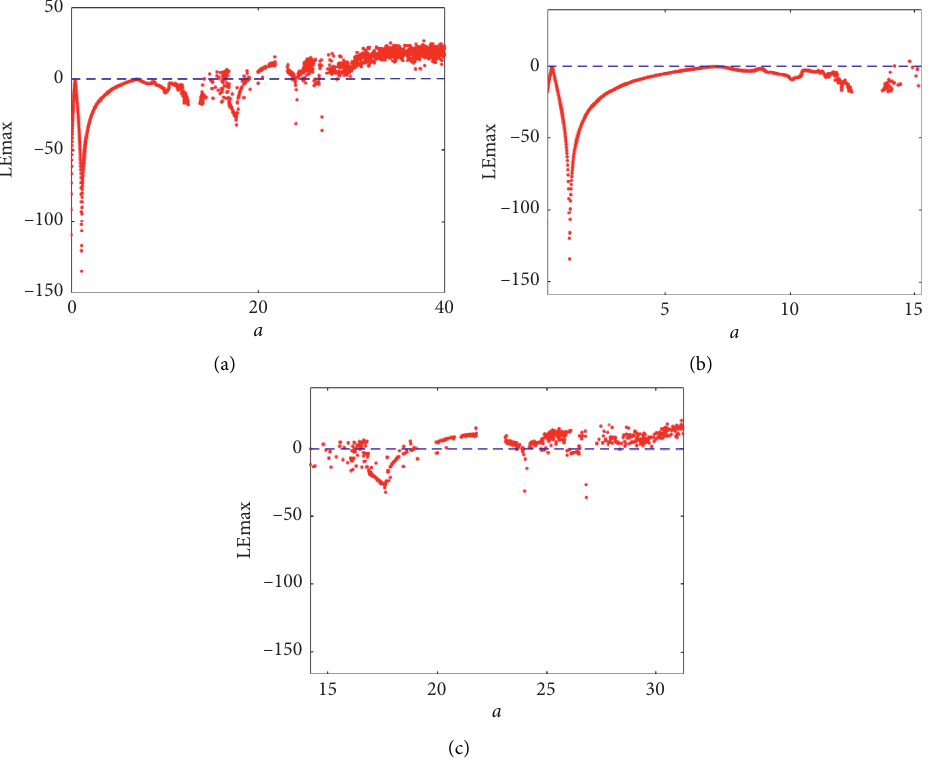
Figure 3: Lyapunov exponent of Hassell mapping ( c � 0 . 8 , β � 22, b � 0.7, and 0 < a <